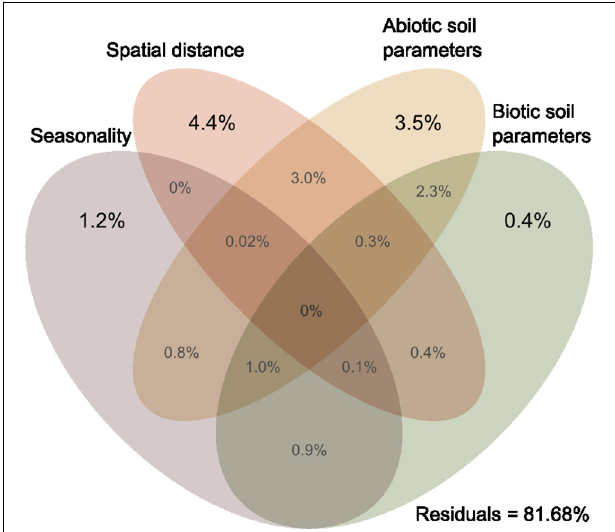
FIGURE 5 | Venn diagram of variance partitioning analysis illustrating the effect of distance, season, and environment (biotic and abiotic edaphic factors) on the cercozoan communities. Values show the percentage of explained variance by each set of variables, and of joined effects in the intersections.